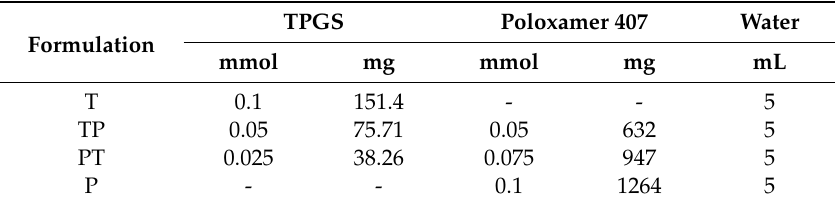
Table 1. Composition of the micellar formulations studied. The amounts of polymers reported, expressed both as mmol and mg, were added to 5 mL of